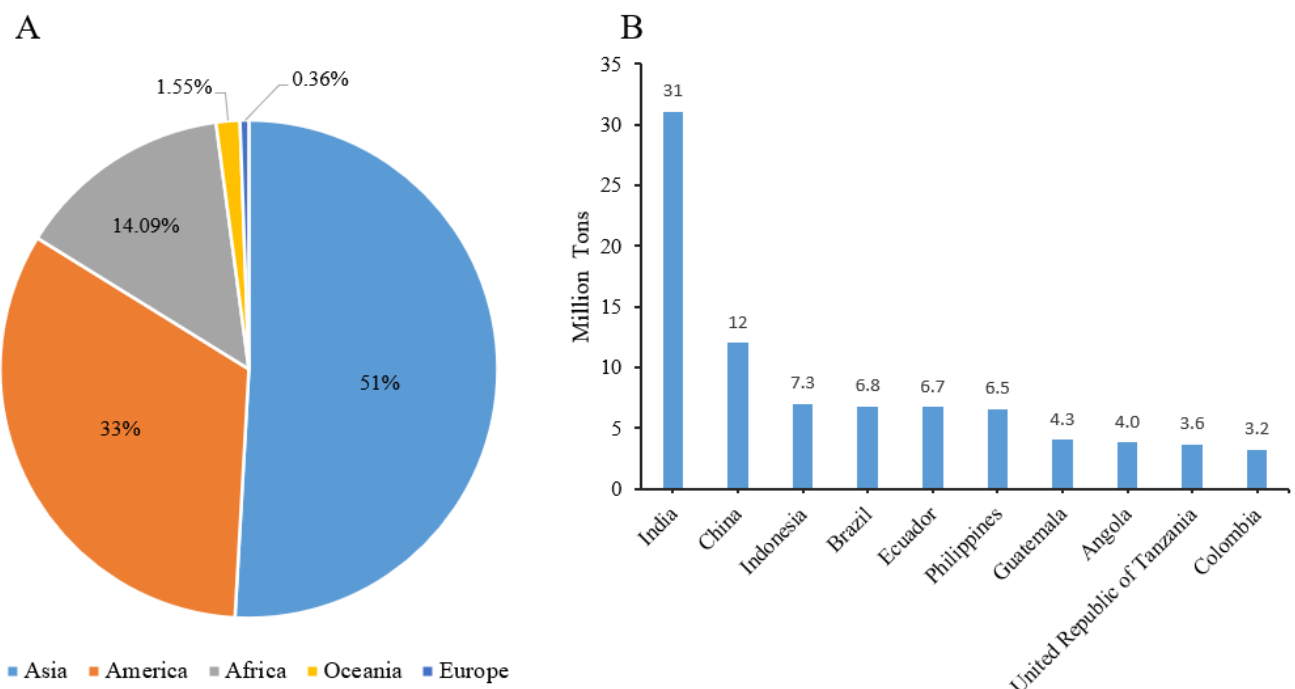
Figure 1. ( A ) Percentage data of banana production by region and ( B ) The top 10 largest banana producing countries. Adapted from [5].